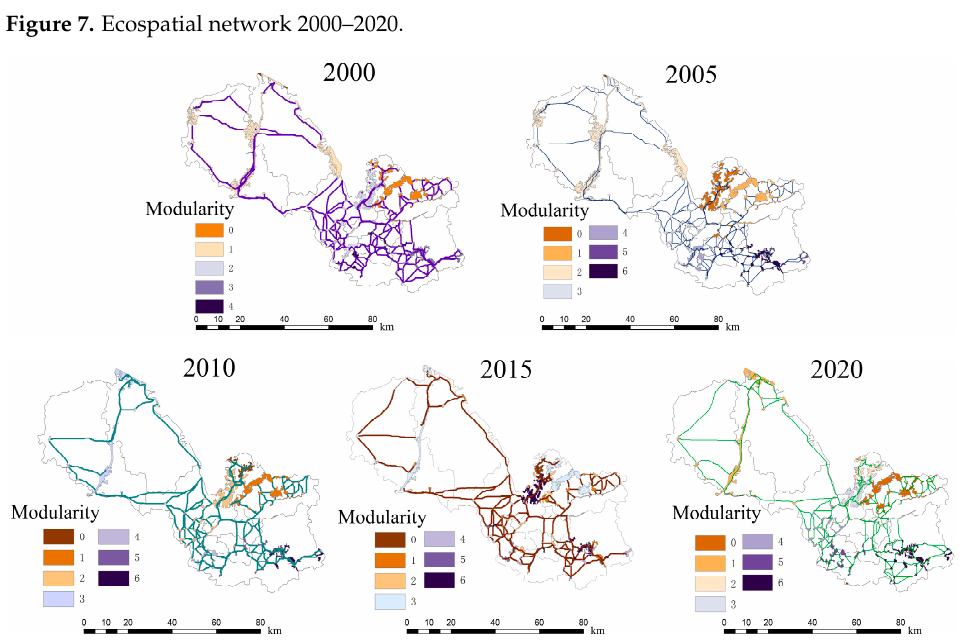
Figure 8. Ecological sources modularity subdivision 2000–2020.